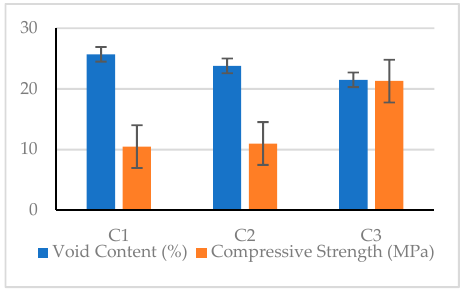
Figure 8. Relationship between compressive strength and void content. Table 13. S / N ratio response table of pervious concretes.